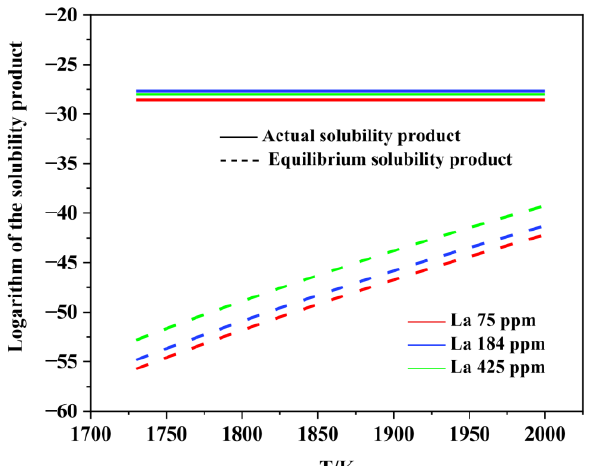
Figure 9. Logarithm of the solubility product as a function of temperature for La 2 O 3 in liquid steel.